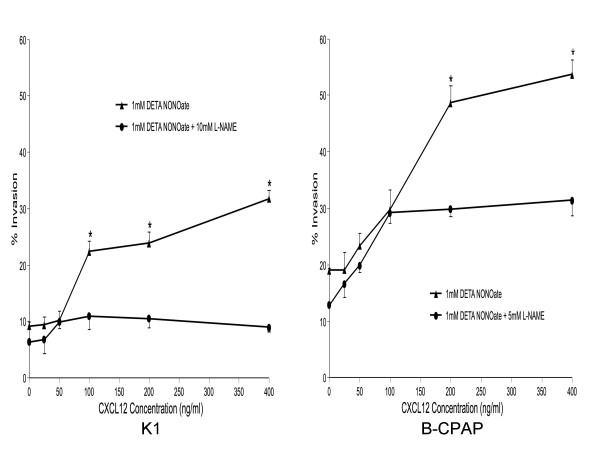
CXCL12 induced the chemoinvasion of papillary thyroid cancer cells. Cells were seeded into the upper compartments of Matrigel Invasion Chambers as described in Materials and Methods. Uncoated or Matrigel-coated membranes separated the upper compartments from lower compartments containing the indicated concentrations of CXCL12. Cells were treated with DETA NONOate with or without L-NAME. Two days later, cells that had migrated to the bottom of the membrane were stained and counted. The percentage of invasive cells (% Invasion) was calculated as the number of cells penetrating the Matrigel-coated membranes divided by the number penetrating the uncoated membranes. Determinations were performed in triplicate and expressed as mean of three experiments ± SE. * indicates significant difference (p < 0.05) from L-NAME-treated cells.